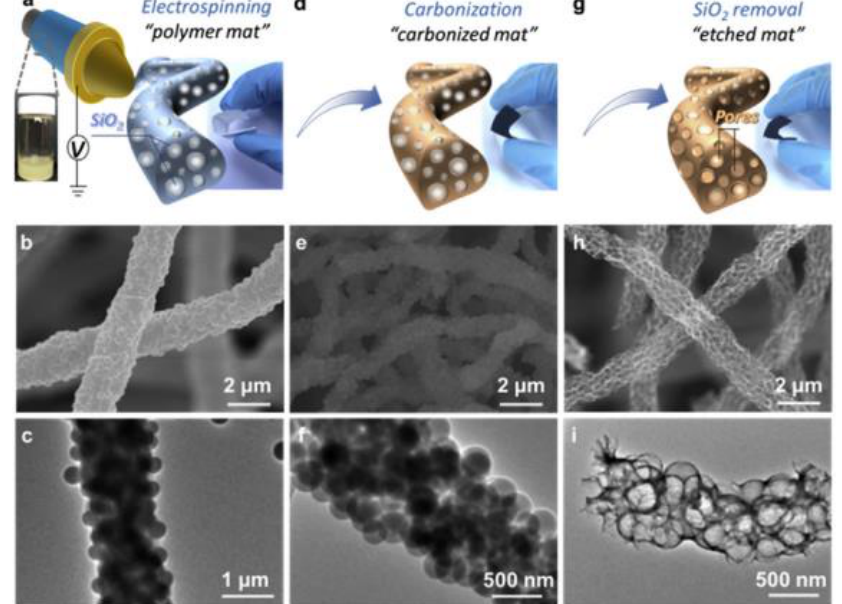
Figure 20. ( a , d , g ) Fabrication schematic of nitrogen-enriched carbon fiber (NCF) mat and related ( b , e , h ) SEM and ( c , f , i ) TEM images. ( a – c ) Polyacrylonitrile (PAN)/polyvinyl pyrrolidone (PVP)/SiO 2 polymer fibers; ( d – f ) carbon/SiO 2 carbonized fibers; ( g – i ) NCF fibers (reproduced from reference [59] with permission. Copyright 2016, Elsevier).